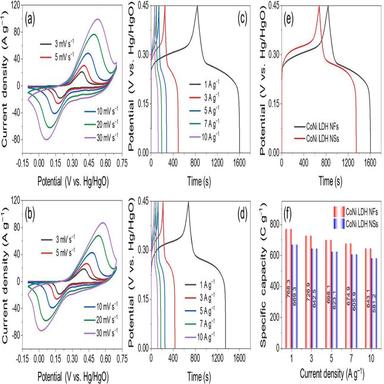
Electrochemical performance of CoNi LDHs measured in three-electrode system: the CV curves of (a) CoNi LDH NFs and (b) CoNi LDH NSs electrodes tested at scan rate ranging from 3 to 30 mV s − 1 , the GCD curves of (c) CoNi LDH NFs and (d) CoNi LDH NSs tested at current density between 1 and 10 A g− 1 , (e) the GCD curves of CoNi LDH NFs and CoNi LDH NSs at 1 A g− 1 , and (f) the rate performance of CoNi LDH NFs and CoNi LDH NSs electrodes.